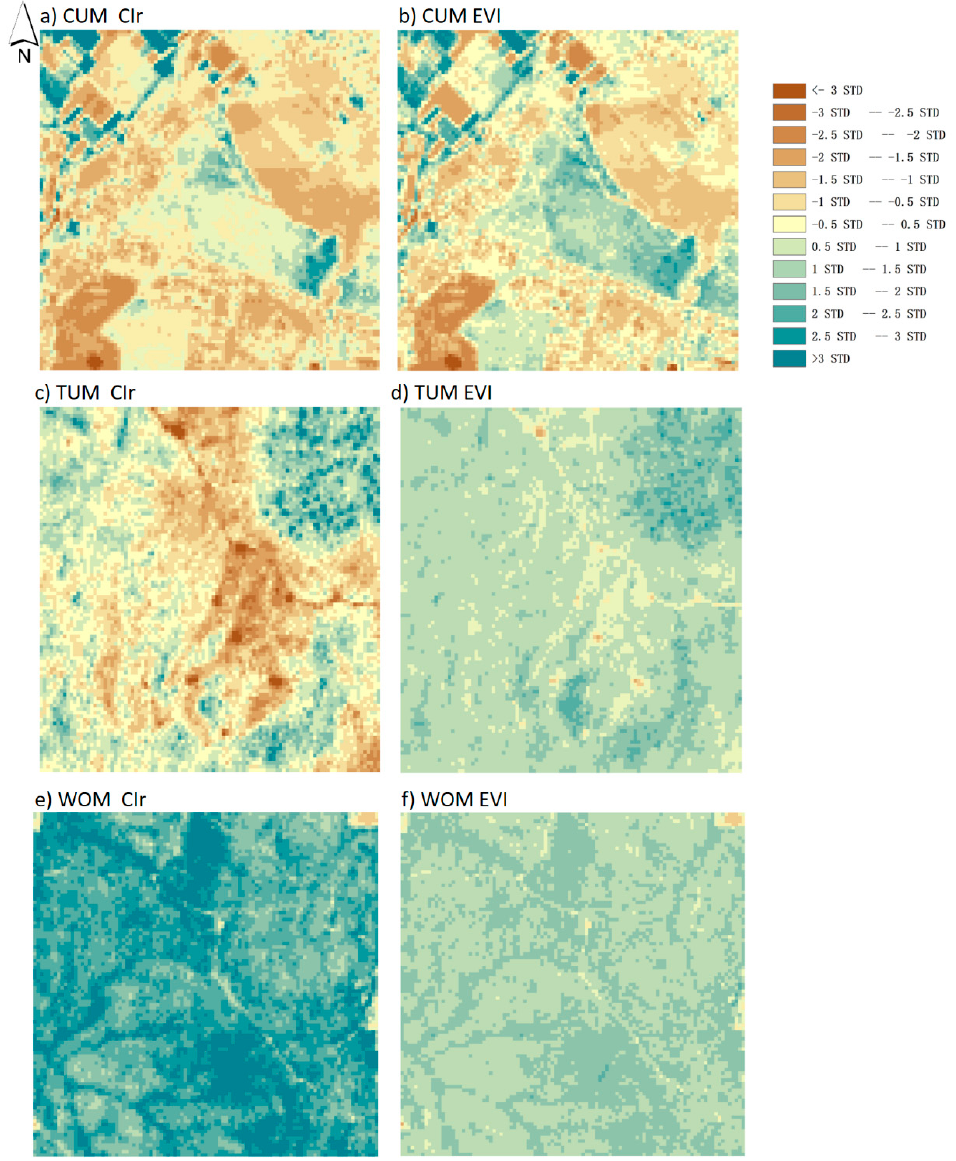
Figure 7. Hierarchical normalized vegetation index of CIr and enhanced vegetation index (EVI) near flux towers. All of the VI values in the 3 × 3-km spatial window were normalized from 0 to 1 and then classified by the different levels of standard deviation. The subfigures show the CIr and EVI values from 1 January to 10 January 2018, under conditions of no cloud cover. The spatial resolution is 30 m.